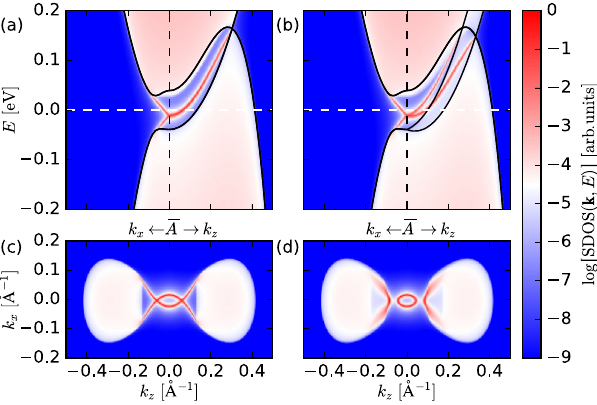
FIG. 5. (010) surface of the k · p model given in Eq. (B3). (a) [(b)] SDOS (the black lines show the bulk dispersion for k and (c) [(d) the surface Fermi surface with [without] inversion